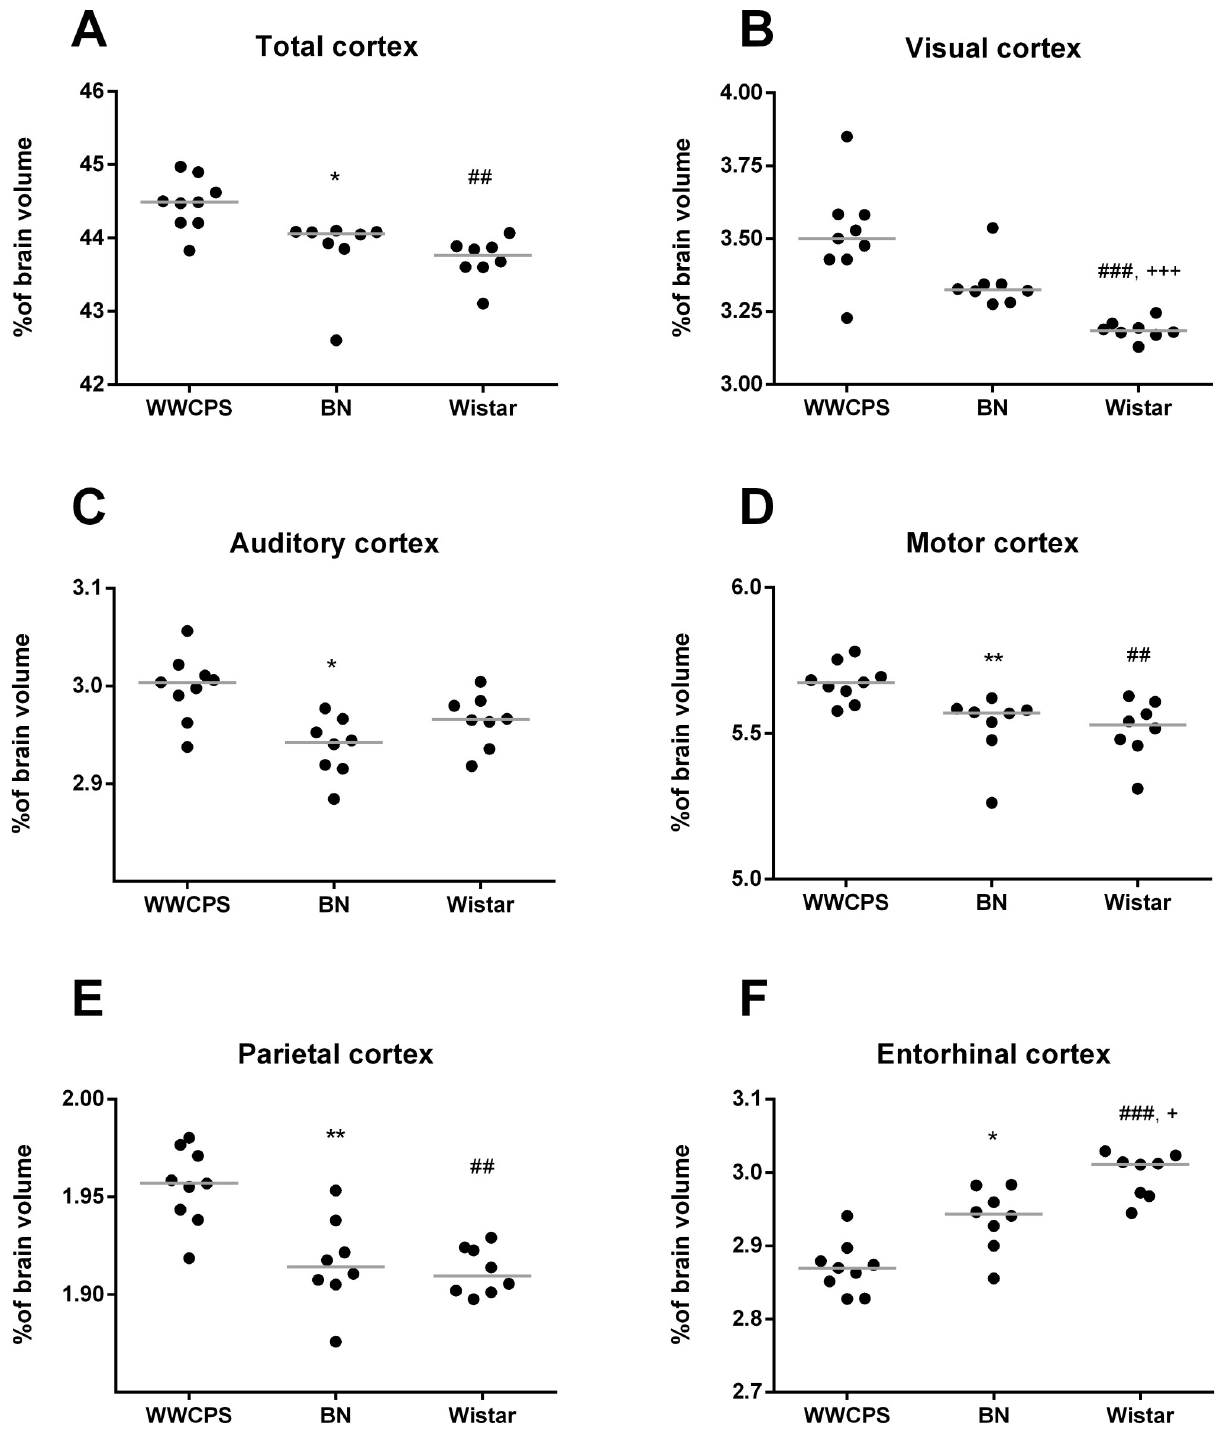
Fig 5. Relative volumes (normalized to individual brain volumes) of cortical brain structures in WWCPS, BN and Wistar rats. Lines represent medians, dots represent individual values. Symbols represent Bonferroni corrected significance levels: � p < 0.017, �� p < 0.003 BN vs. WWCPS; ## p < 0.003, ### p < 0.0003 Wistar vs. WWCPS; + p < 0.017, +++ p < 0.0003 BN vs. Wistar.